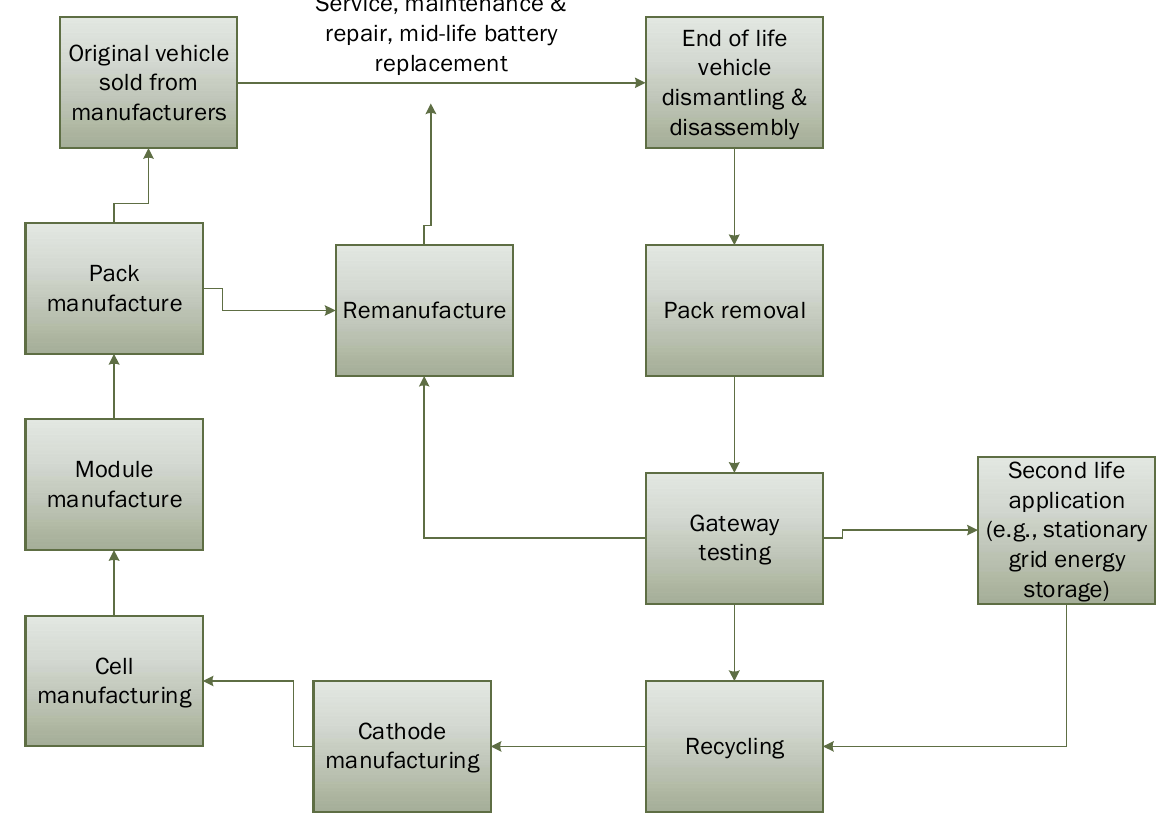
Figure 14. EV battery in circular economy model, redrawn from Ahuja, Dawson and Lee [99]. Tan, Wang, Chen, Li, Sun, Liu, Yang, Xiang, Sun and Duan [82] compared elegant